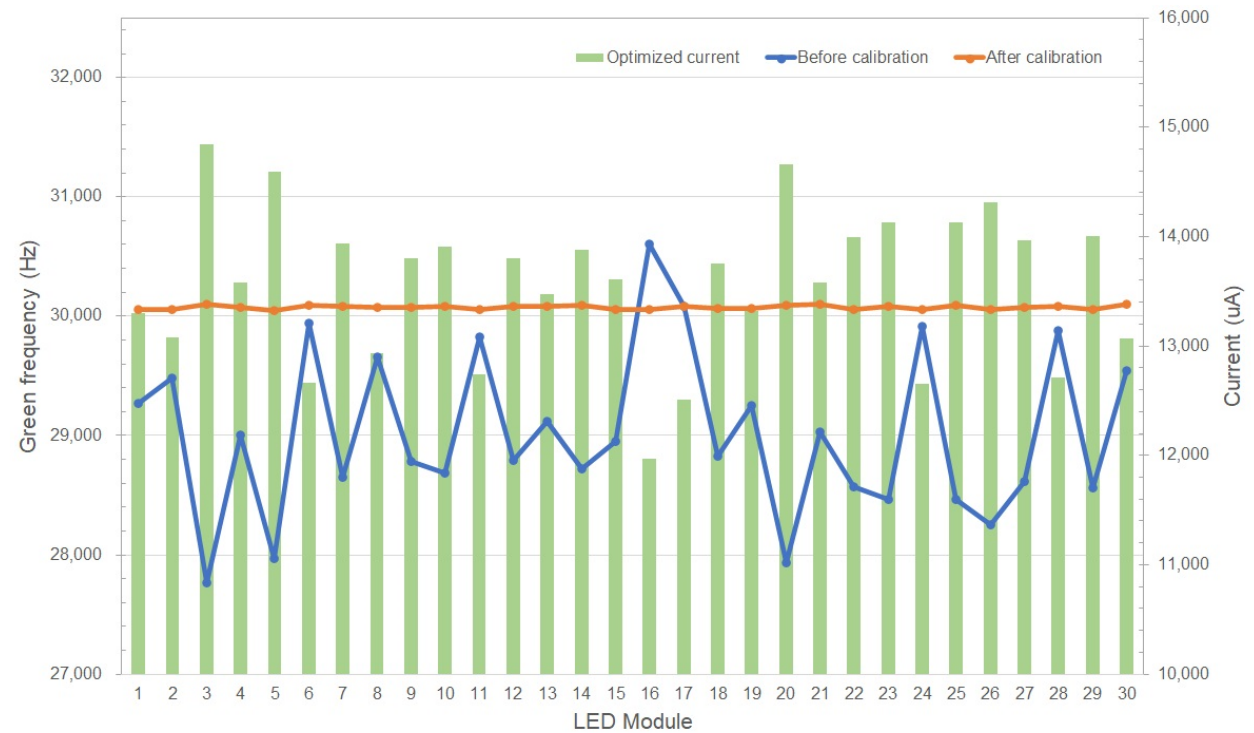
Figure 11. Green frequency and current value before and after calibration of LED module.